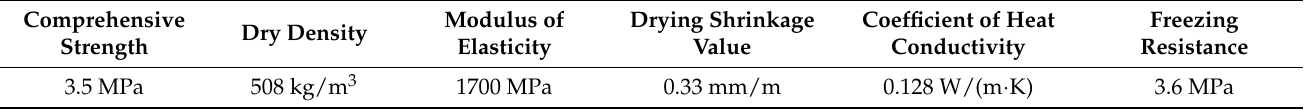
Table 3. Technical specifications of the AAC panel.